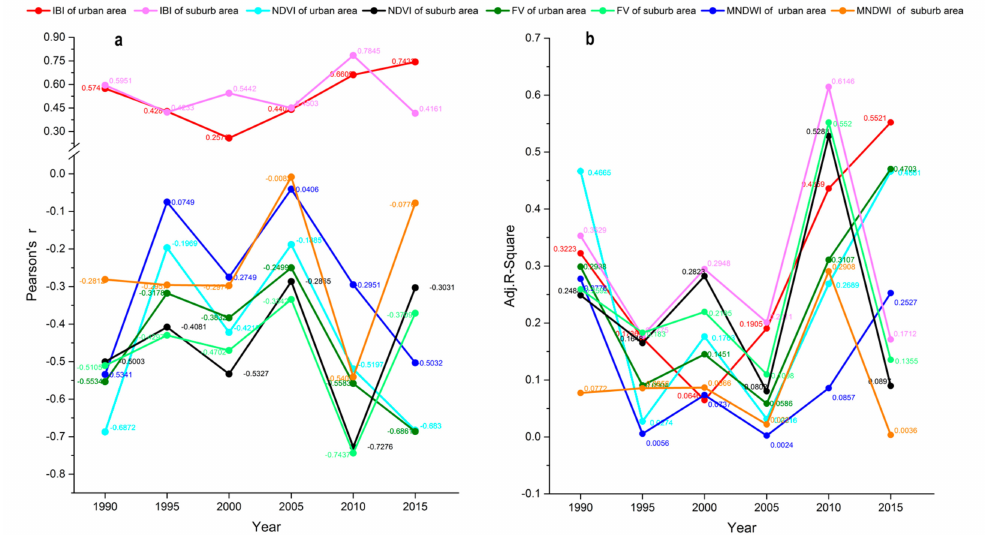
Figure 7. Linear correlation analysis of LST versus the remote sensing ground indexes (NDVI, FV, IBI and MNDWI) in urban and suburban areas: ( a ) Pearson’s correlation coefficients (r); ( b ) adjusted R-square values (R 2 adj ) of spatial linear